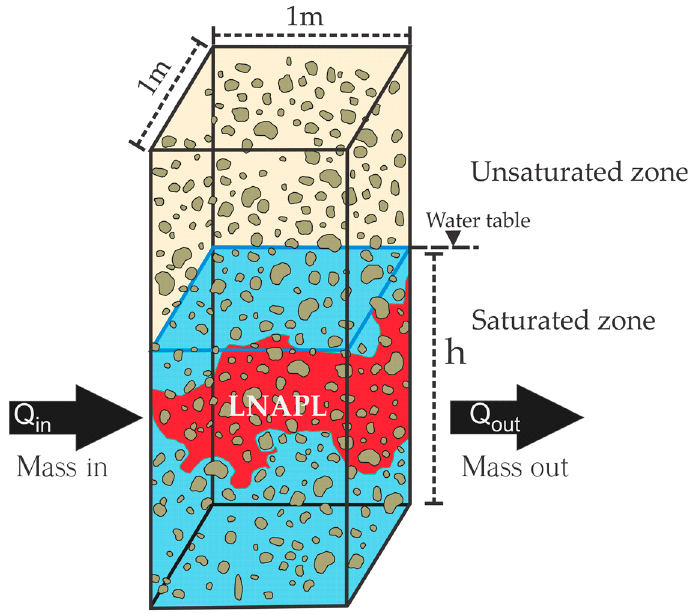
Figure 1. Schematic illustration of the representative elementary volume that encompasses a discrete portion of the light non-aqueous phase liquid (LNAPL) source zone used in the proposed algorithm.